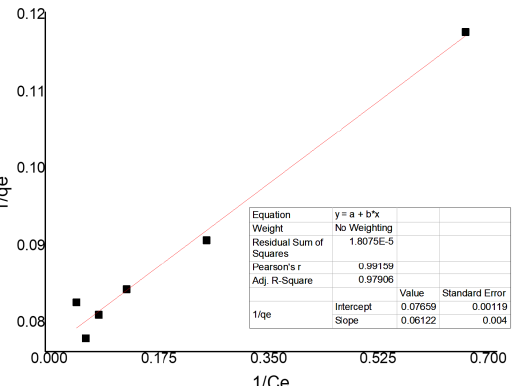
Figure 12. Kinetic study of DR16 adsorption process. R L values demonstrate the type of adsorption, with R L = 0 attributed to irreversible adsorption, 0 < R L < 1 for favorable adsorption, R L = 1 for linear adsorption, and R L > 1 for unfavorable adsorption. R L for DR16 removal was obtained as 0.444235, which confirmed the adsorption type is favorable [44]. The intercept, slope, q max , K L , R L , and R 2 are listed in Table 6.